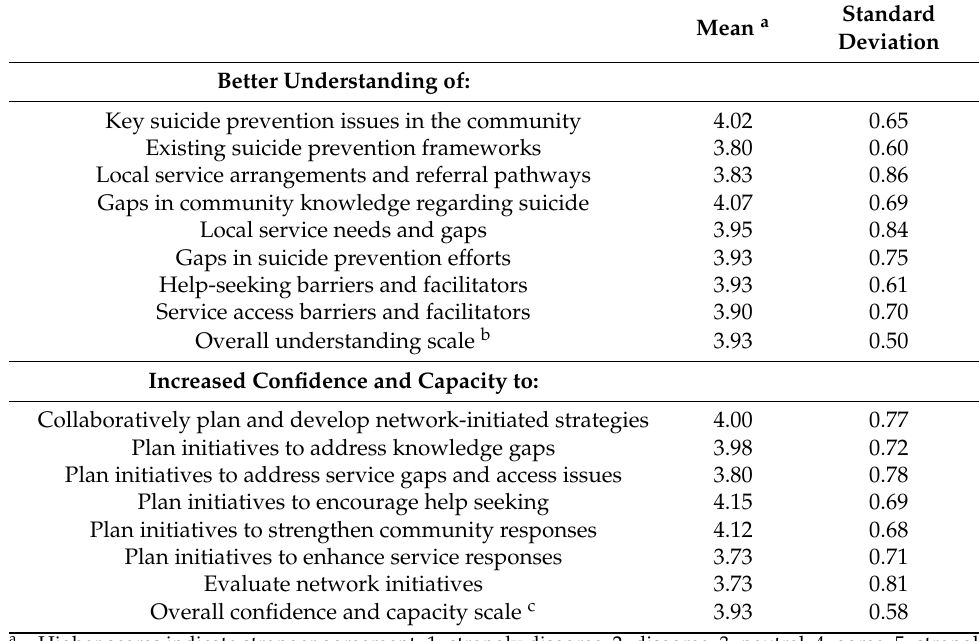
Table 3. Perceived network member outcomes (understanding, confidence, and capacity) ( N =